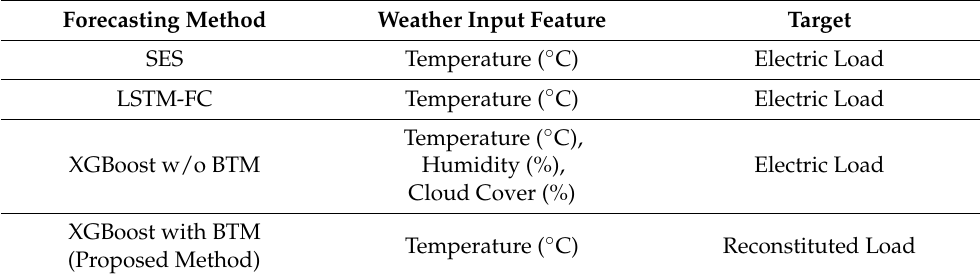
Table 3. The weather input feature and target data for the forecasting methods for comparison.